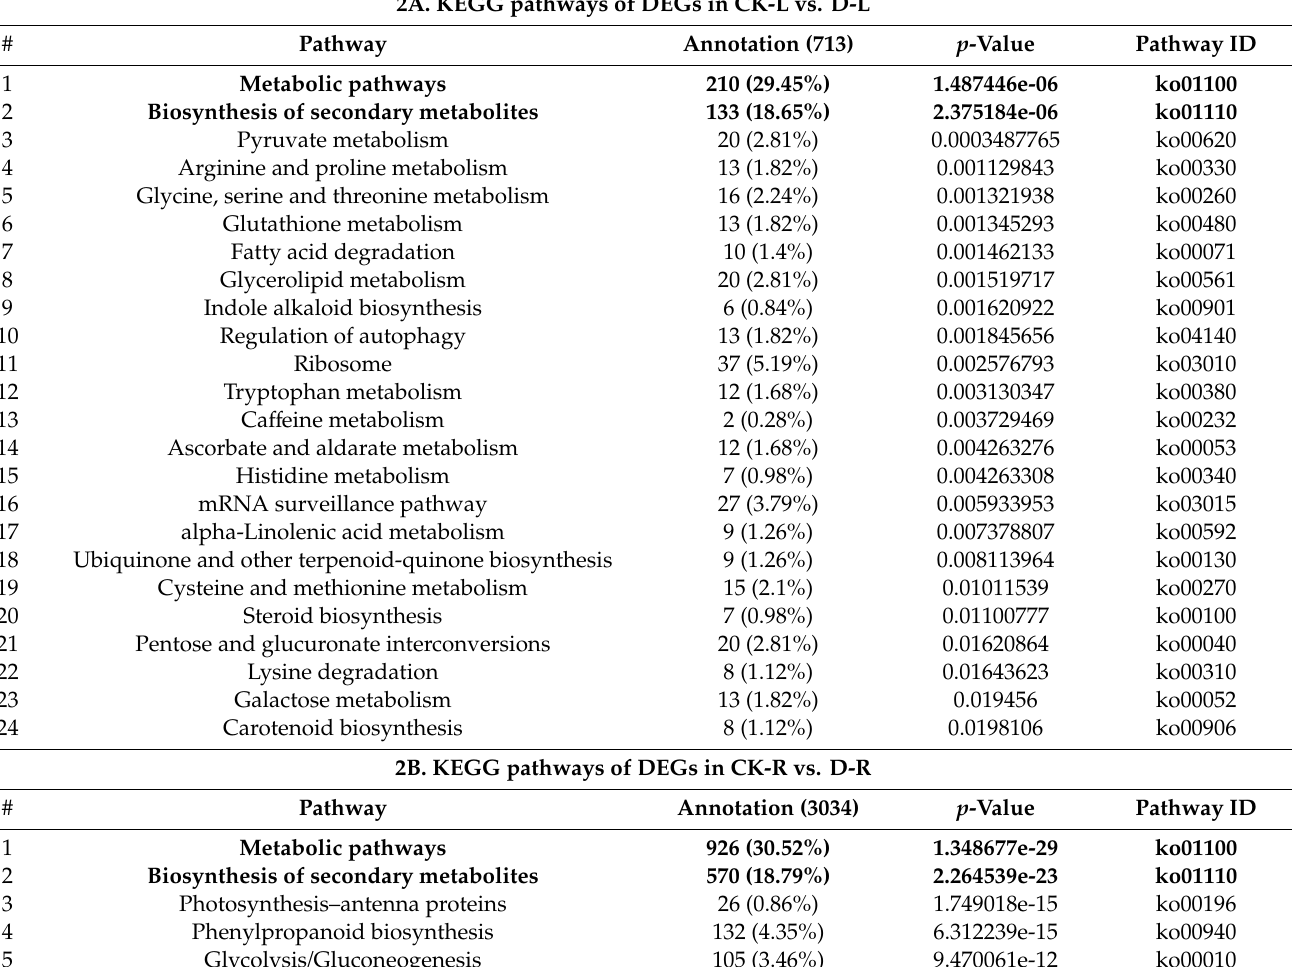
Table 2. KEGG pathways of